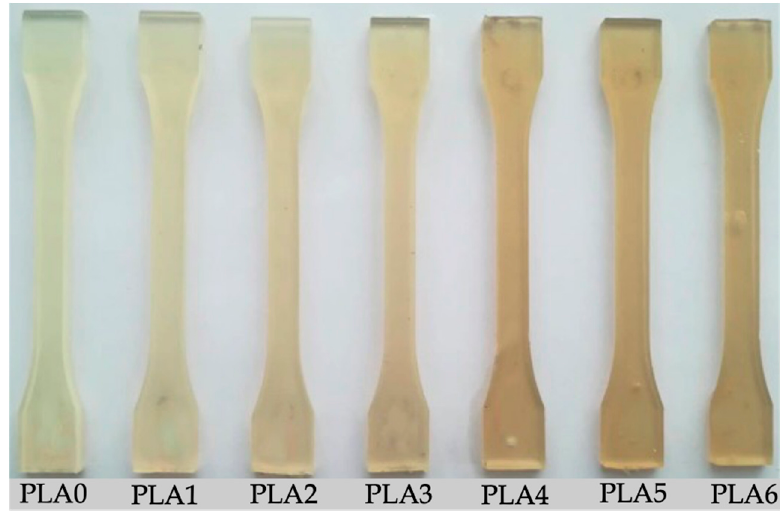
Figure 6. Visual aspect of the injection-molded polylactide (PLA) pieces subjected to different reprocessing cycles. Table 5. Color parameters ( L*, a*, b*, and ∆ E * ab ) and yellowness index (YI) of the injection-molded polylactide (PLA) pieces subjected to di ff erent reprocessing